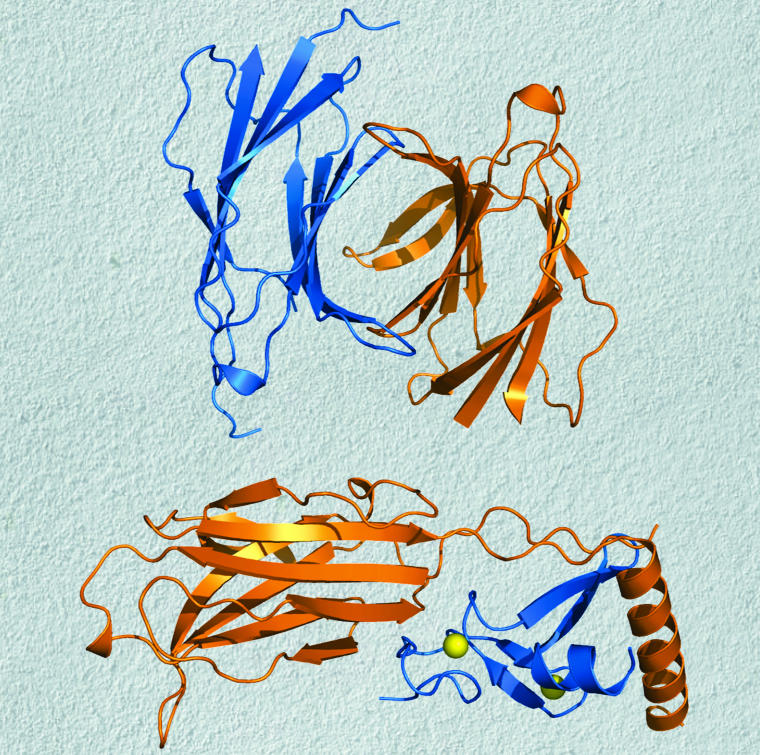
The crystal structures of a Munc13-1 homodimer (top) and a Munc13-1/RIM2α heterodimer (bottom) show how a C
2 domain participates in two distinct protein–protein interactions that might couple synaptic vesicle priming to presynaptic plasticity.